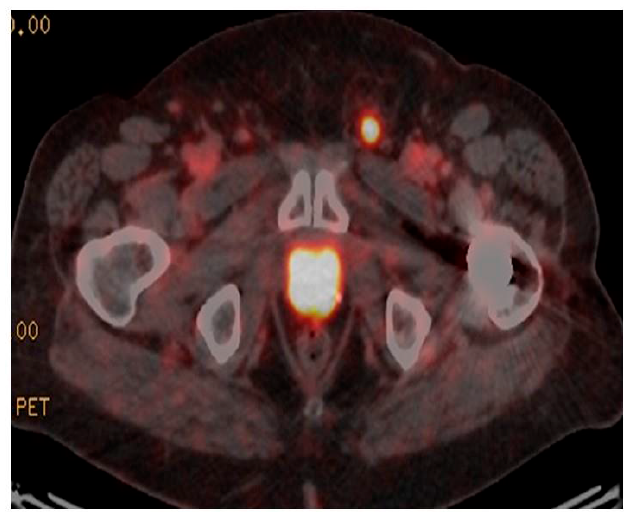
Figure 2. Staging 68 Ga-PSMA PET/CT. Gleason 4 + 5. PSA 19 ng/mL. Intense 68 Ga-PSMA avid primary disease in prostate with 68 Ga-PSMA avid superficial left inguinal node metastasis.